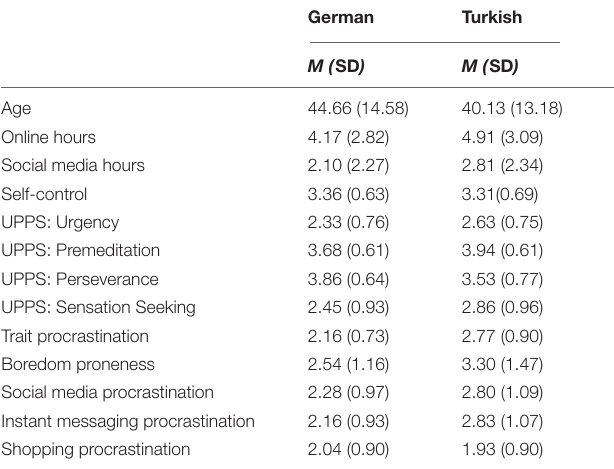
TABLE 2 | Means and standard deviations of